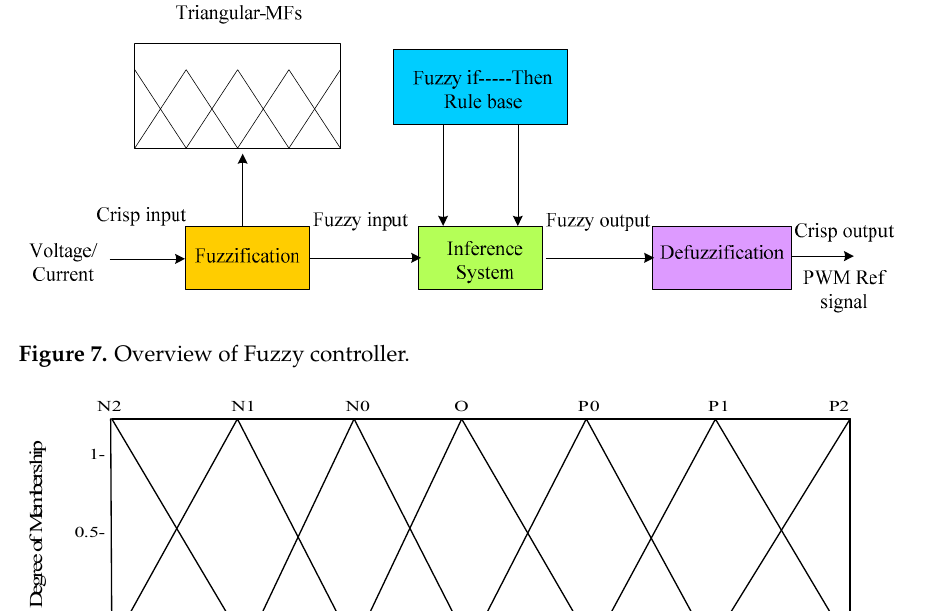
Figure 8. MF for “Er”.